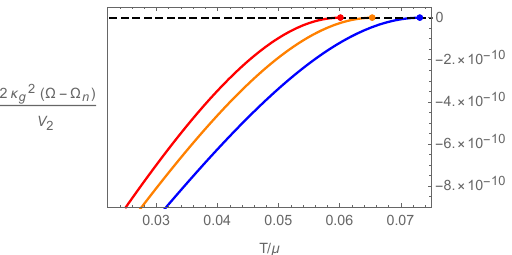
Figure 3 . The relative value of grand potential density with respect to the normal phase in the case of b = 0 . 0001 and H = − 0 . 5 (red line), 0 (orange line), 0 . 5 (blue line), with the three colored points mark the critical